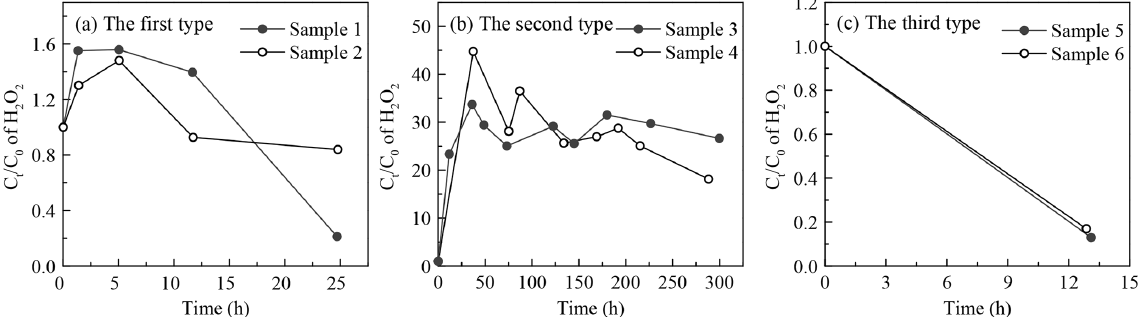
Figure 6. Time profiles of aerosol-phase H 2 O 2 evolution in the extracted solution. (a) The first type: samples 1 and 2 were collected on 29 December 2018. (b) The second type: samples 3 and 4 were gathered on 31 December 2018–1 January 2019. (c) The third type: samples 5 and 6 were collected on 2 January 2019. C t and C 0 denote molar concentrations of H 2 O 2 in the extracted solution at time = t and time = 0.